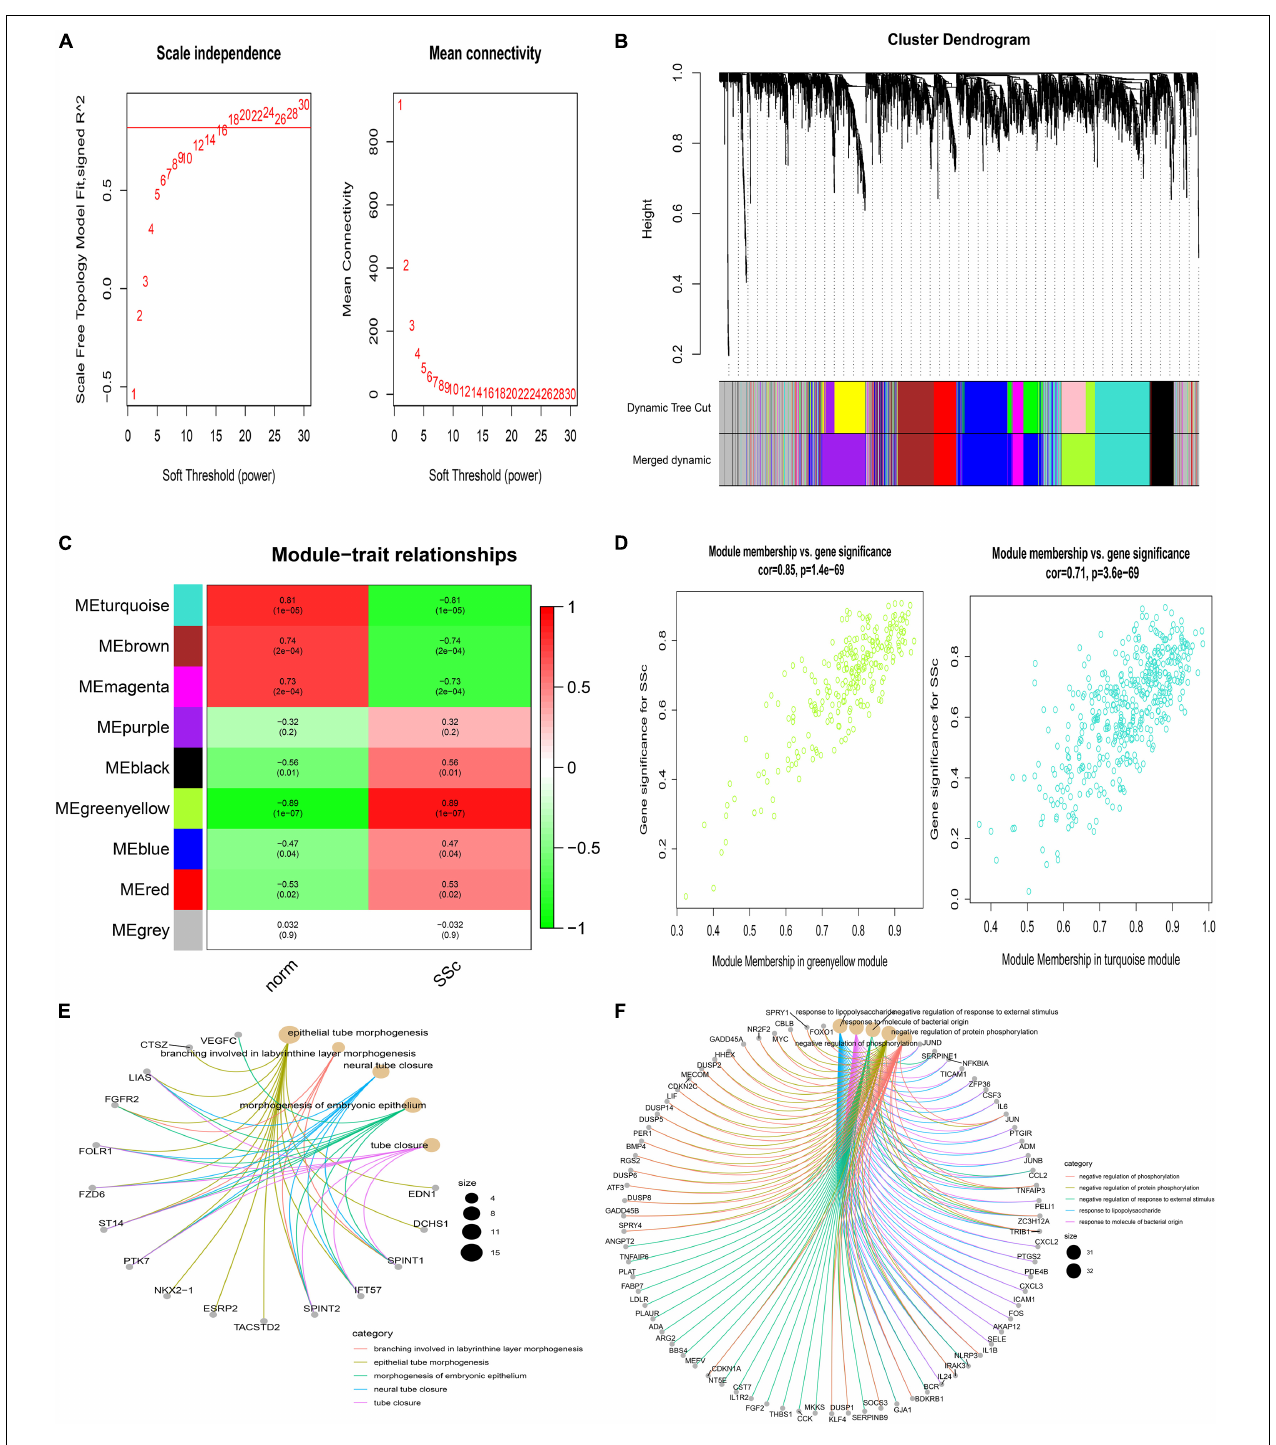
FIGURE 4 | Construction of weighted gene co-expression network of GSE81292. (A) Analysis of the scale-free topology model fit index for soft threshold powers ( β ) and the mean connectivity for soft threshold powers. (B) Cluster dendrogram of the co-expression network modules was produced based on topological overlap in the mRNAs. Each branch means one gene. Each color means one co-expressed module. Twelve modules were merged into nine modules. (C) Heatmap of the correlation between module eigengenes and clinical traits. P -value is shown in each color cell coded by the correlation between modules and traits (red indicates positive correlation, while green indicated negative correlation). (D) Scatter plot of module eigengenes in the greenyellow and turquoise module. (E) GO enrichment of genes in the greenyellow module. Each color of lines means one enrichment category for genes. (F) GO enrichment of genes in the turquoise module. SSc, systemic sclerosis; GO, gene